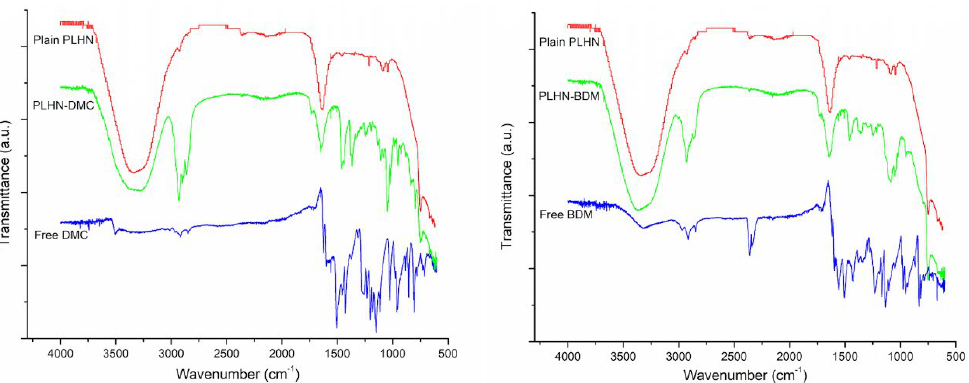
Figure 4. FT–IR spectra of DMC and BDM–loaded PLHNs, plain PLHNs and free DMC and BDM.